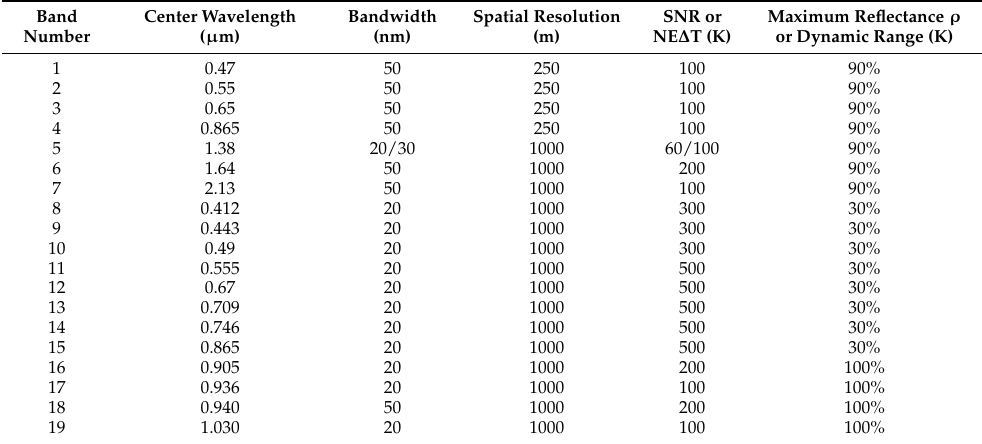
Specifications of the Fengyun 3D Advanced Medium Resolution Spectral Imager (FY3D